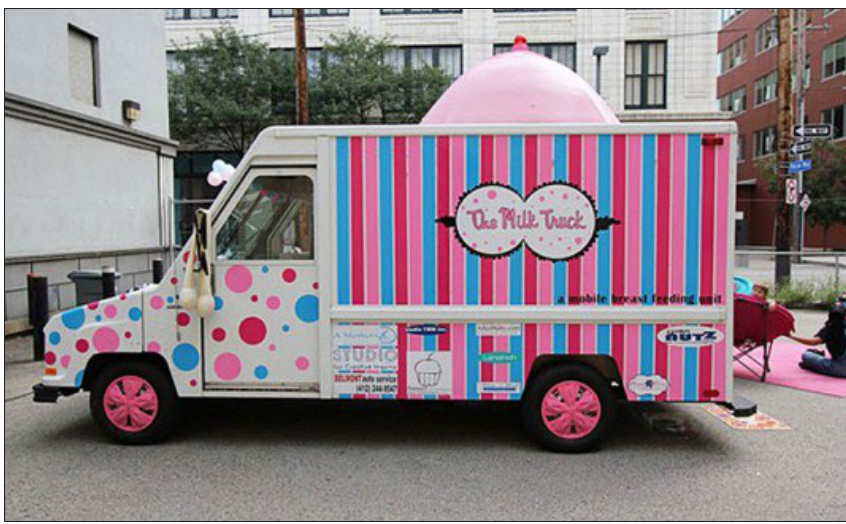
Figure 4: Jill Miller, The Milk Truck, 2011–2012 at the Pittsburgh